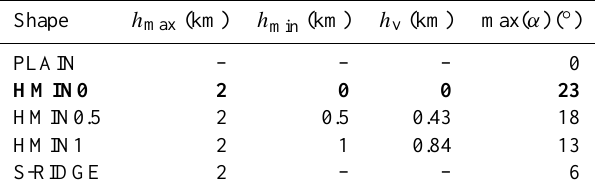
Table 1. Overview and abbreviations of model topographies as de- scribed by Eqs. (1) and (2). HMIN0 corresponds to the reference run. All mountain topographies consist of a 60km broad symmet- ric mountain range with a 30km wide flat foreland on each side (see Fig. 1). h max and h min are the maximum heights of the upper and lower envelope, respectively. h v is the effective height of the valley floor and max( α ) the maximum slope inclination. The cases S-RIDGE and PLAIN refer to sensitivity runs with a single ridge and a flat plain,